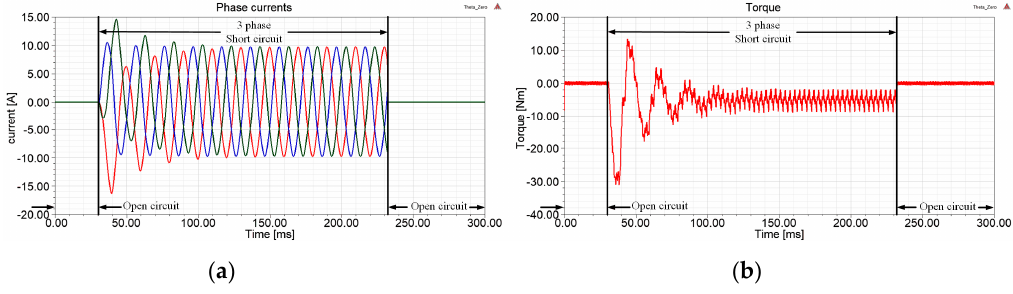
◦ C: ( a ) currents and ( b ) torque.